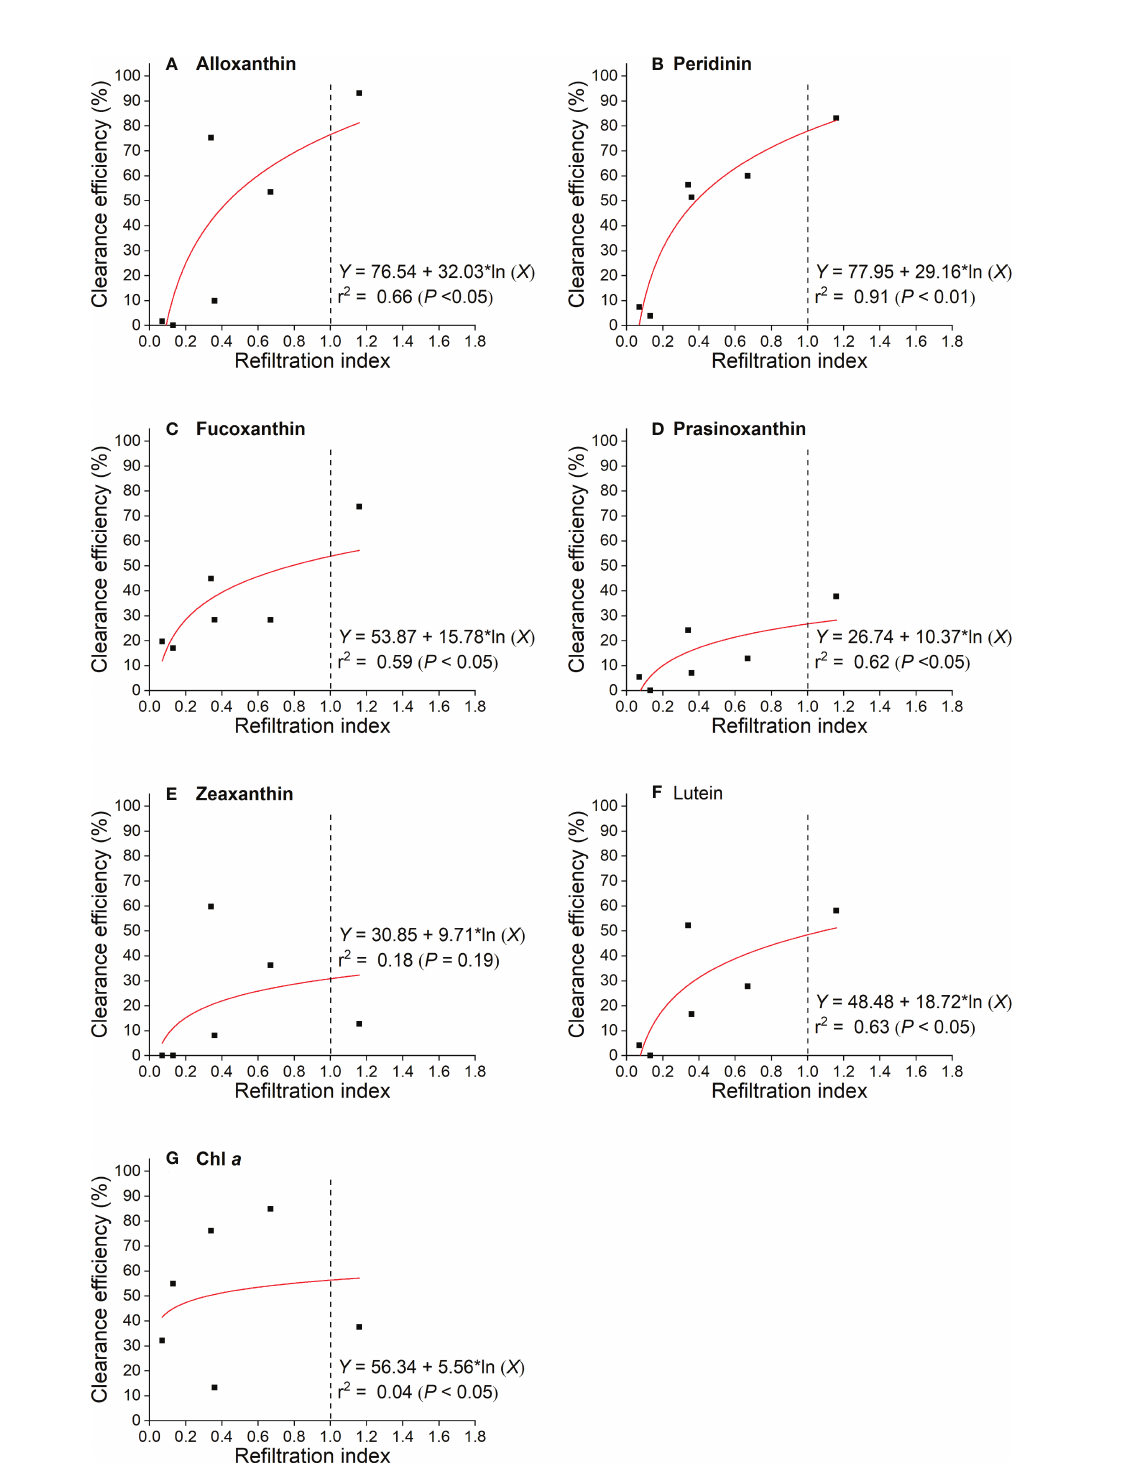
FIGURE 6 Logarithmic relationships between clearance ef fi ciency of phytopigments and re fi ltration index by M. coruscus